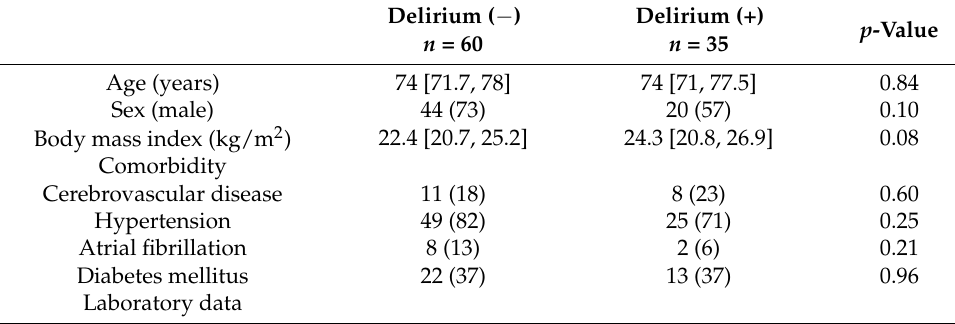
Figure 1. Patient flowchart. CABG: coronary artery bypass grafting, ICU: intensive care unit. Table 1. Demographic characteristics of the patients with and without postoperative